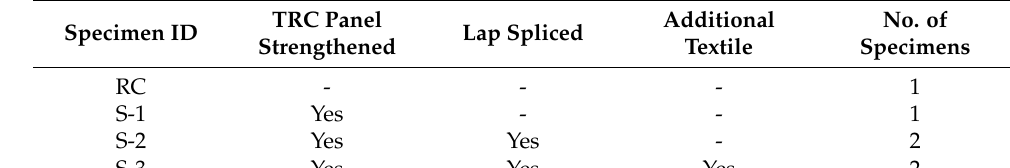
Table 6. Characteristic of full-scale specimens for flexural test.